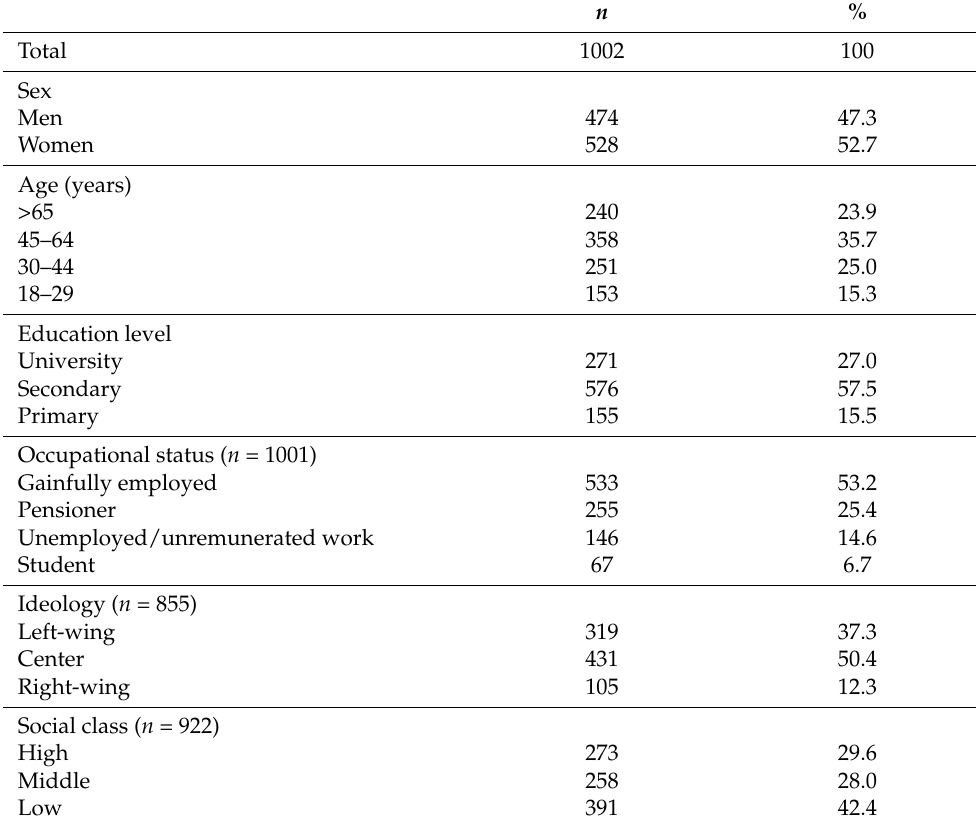
Table 1. Sociodemographic characteristics of the study sample, representative of the Spanish adult population,